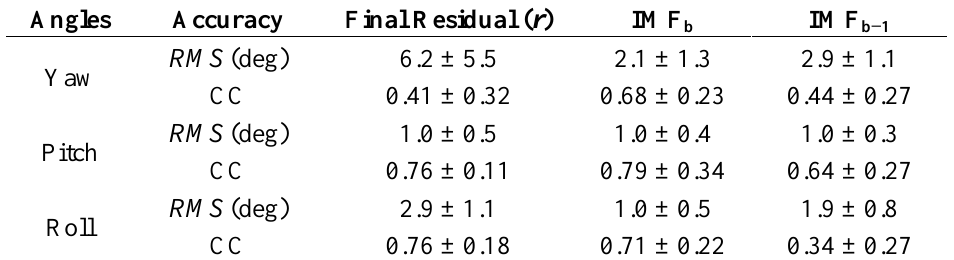
Table 2. Accuracy results obtained during overground walking. Final method outputs are in the IMF b